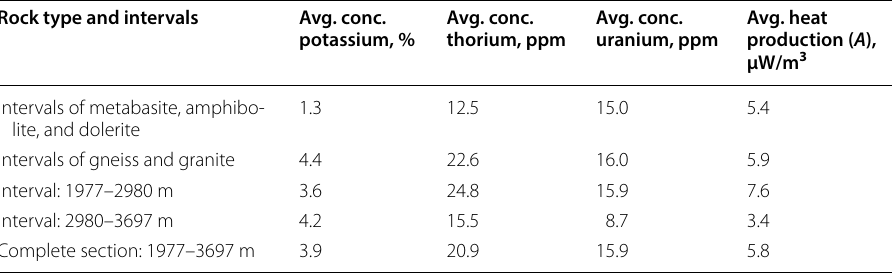
Avg. conc. Avg. conc. Avg. heat potassium, % thorium, ppm uranium, ppm production ( A ), μW/m 3 1.3